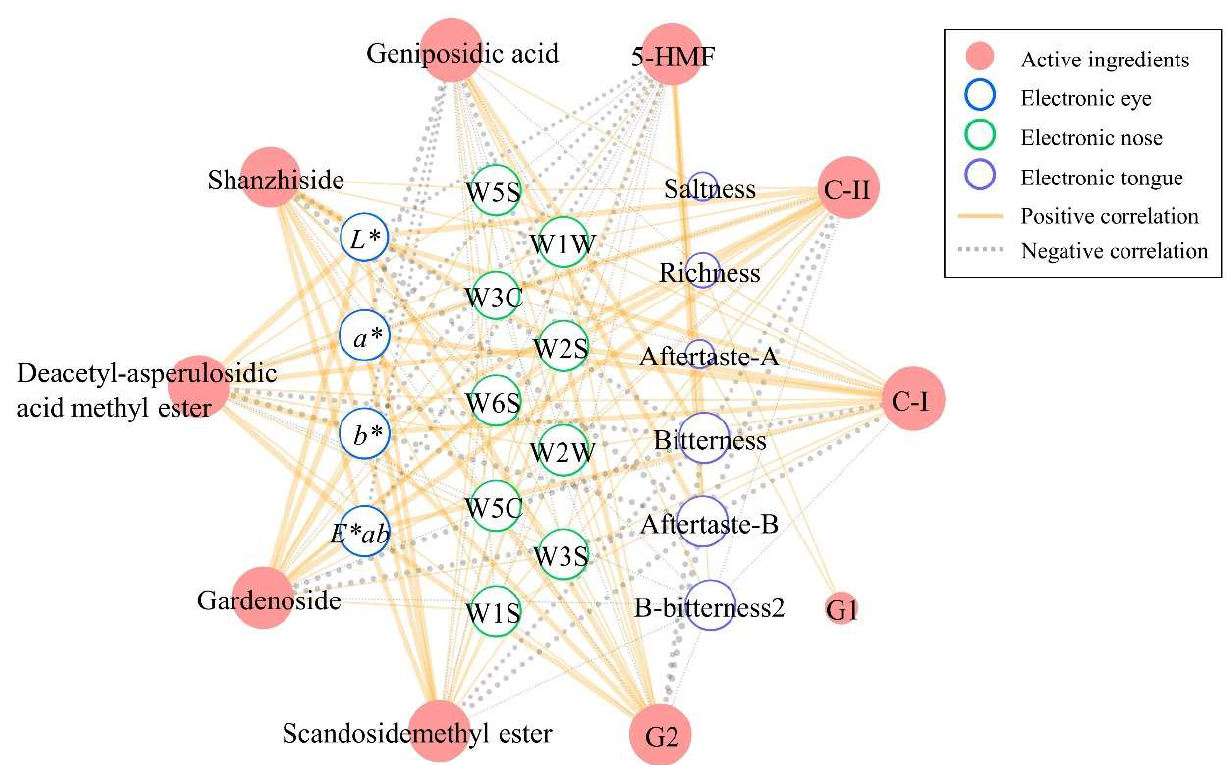
Figure 6. The relationship network presents significant correlations between the components and the indexes of external features. The a* indicates color from red to green, b* represents color from yellow to blue, and E*ab means total chromatic aberration.